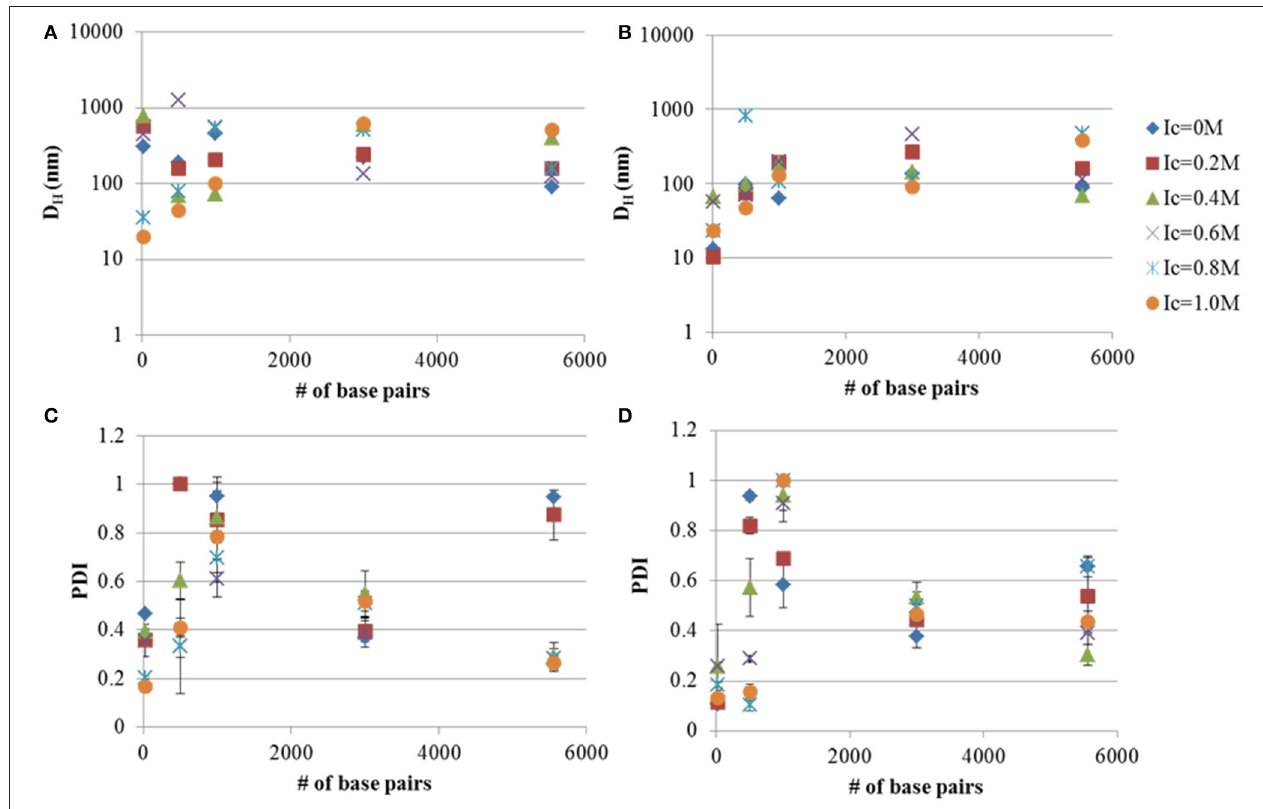
FIGURE 2 | Hydrodynamic diameters (D H ) and PDI measurements of DNA-Tat 2 nano-complexes in MM media with (B,D) and without TBPB (A,C) . The 8:1 Tat 2 :dsRNA charge ratio is also shown for comparison. The relationship between the size of the nucleic acid in terms of # of base pairs and the size of the nano-complexes is shown. Data plotted are means ± s.d. ( n = 3), evaluated using CONTIN.